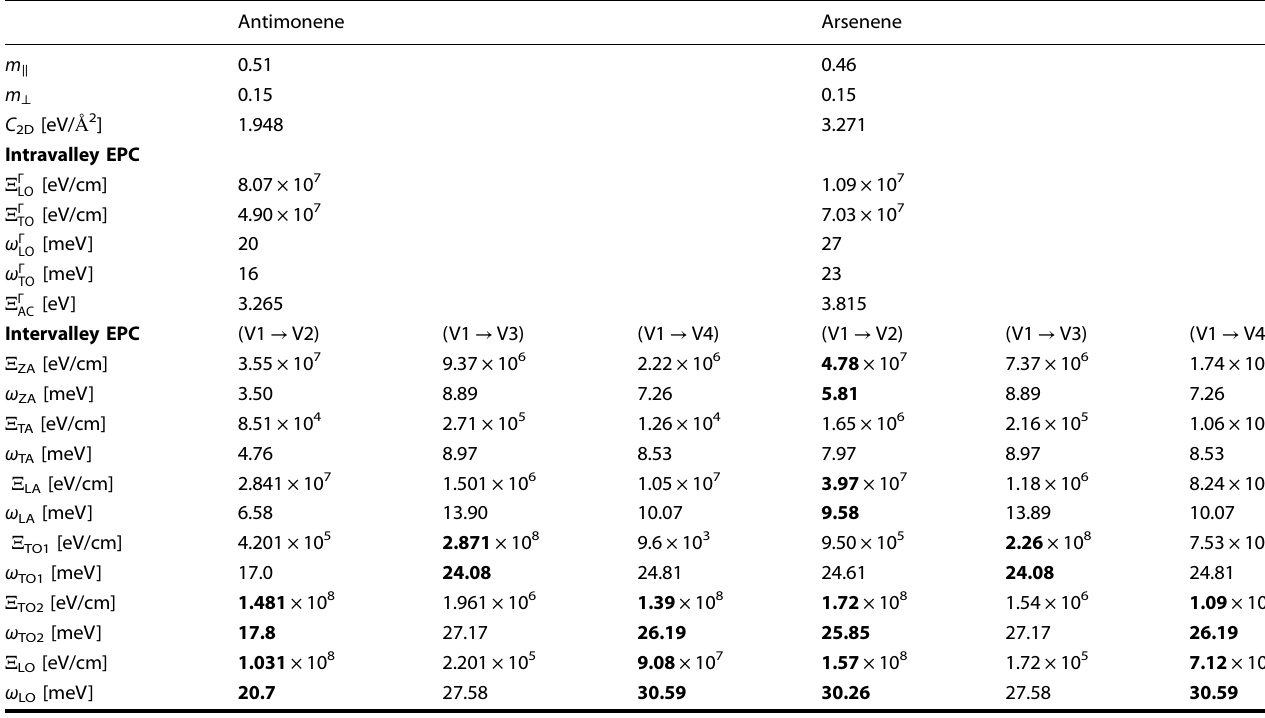
The values of C 2D and Ξ Γ AC are taken from ref. 13 The intervalley EPCs with a deformation potential >4×10 7 are marked in